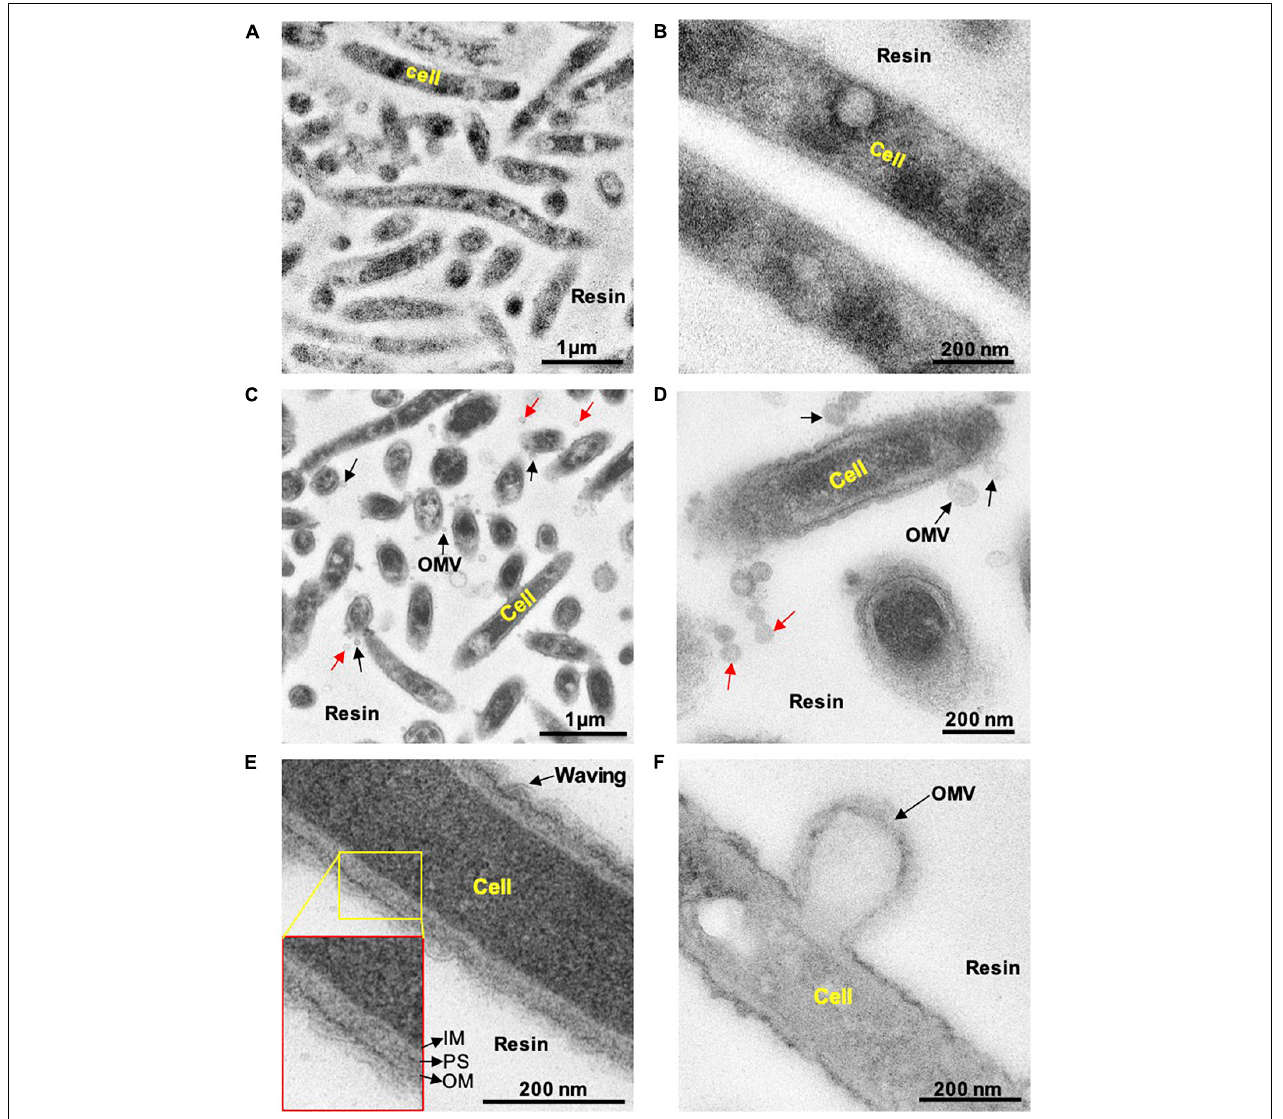
FIGURE 1 | Transmission electron microscopy observation of thin sections of C. Ochracea cells. The TEM images of the specimens that were untreated and treated with Pb, U, and Os heavy metals. (A) General view of cells without heavy metal staining. (B) Magnified view of the cell surface without heavy metal staining (C) A general view of cells with heavy metal staining showing OMVs. (D) Magnified view of the cell surface with heavy metal staining showing OMVs. Black and red arrows indicate cell-attached and non-attached OMVs, respectively. (E) Magnified image of the cell and cell envelope showing membrane waving behavior. The inset shows the inner membrane, periplasmic space, and outer membrane. IM, inner membrane; PS, periplasmic space; OM, outer membrane. (F) Magnified image of OMV-forming